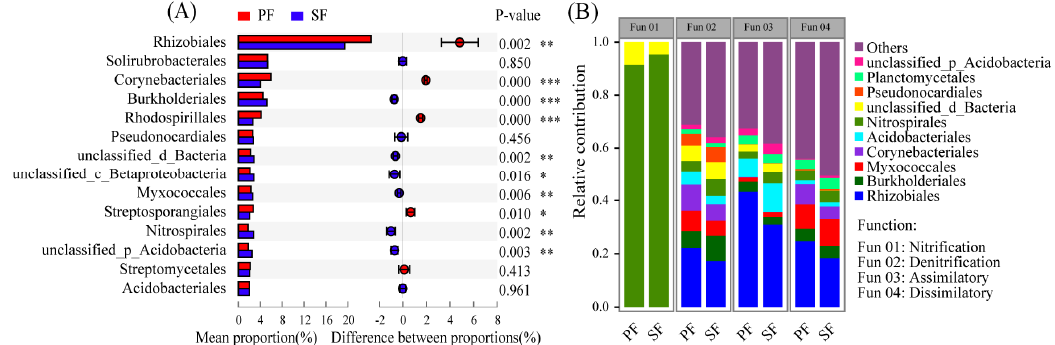
Figure 5. ( A ) Comparison of orders involved in N cycling with relative abundance greater than 2% between primary Korean pine forests (PF) and secondary broad ‐ leaved forests (SF). ( B ) Taxonomic groups involved in the major N cycling processes. Only the top 10 most abundant microbial orders are shown in the figure. Assimilatory: Assimilatory nitrate reduction. Dissimilatory: Dissimilatory nitrate reduction. p < 0.05 *, p < 0.01 **, p < 0.001 ***.